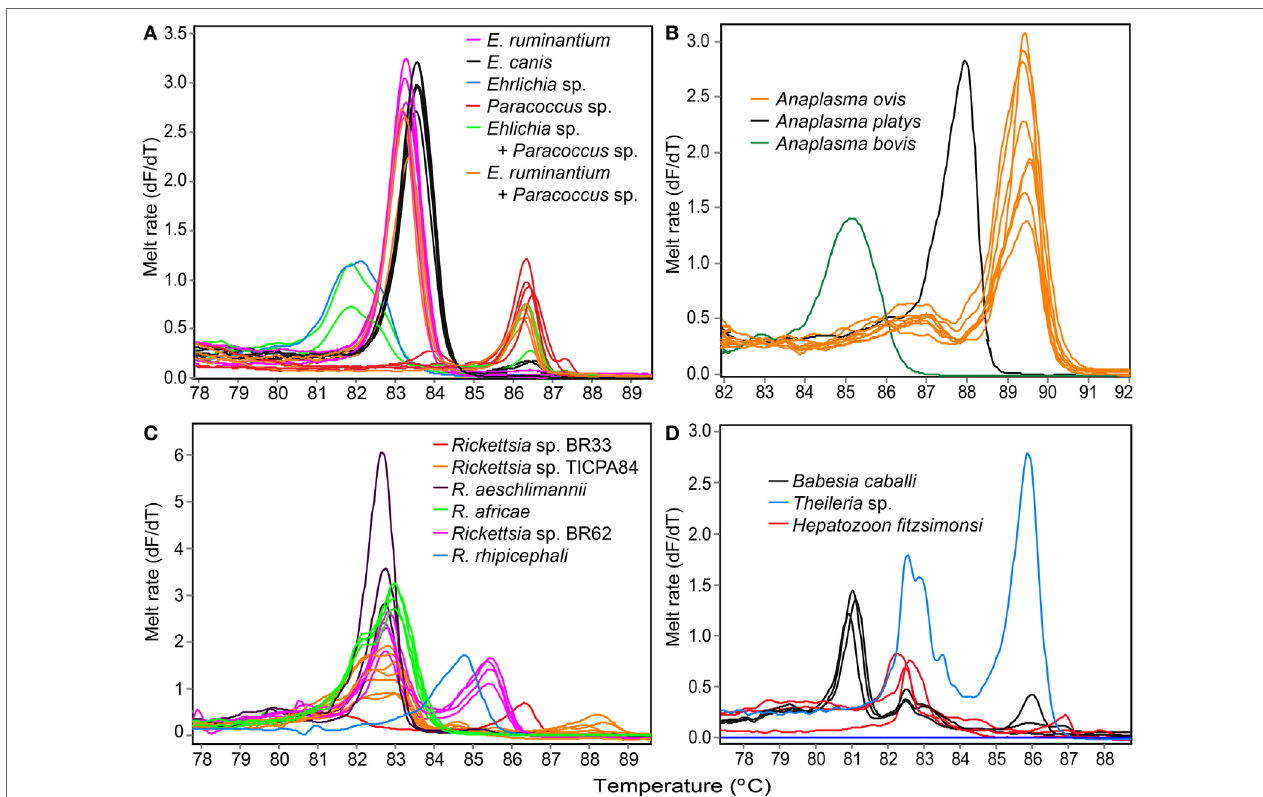
FigUre 2 | Melting rate profiles of tick-borne pathogens in field collected tick samples . PCR amplicon melt rates are represented as change in fluorescence with increasing temperature (dF/dT) of (a) Ehrlichia spp. and Paracoccus sp. 16S rRNA, (B) Anaplasma 16S rRNA, (c) Rickettsia rpmE /tRNA fMet , and (D) apicomplexan hemoparasite 18S rRNA gene segments.